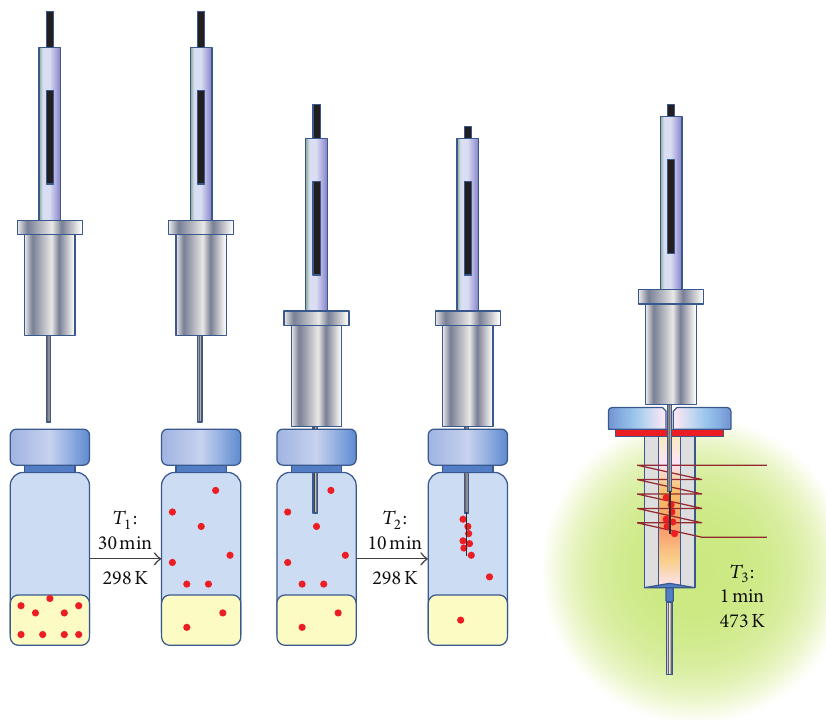
Figure 3: SPME sampling procedure